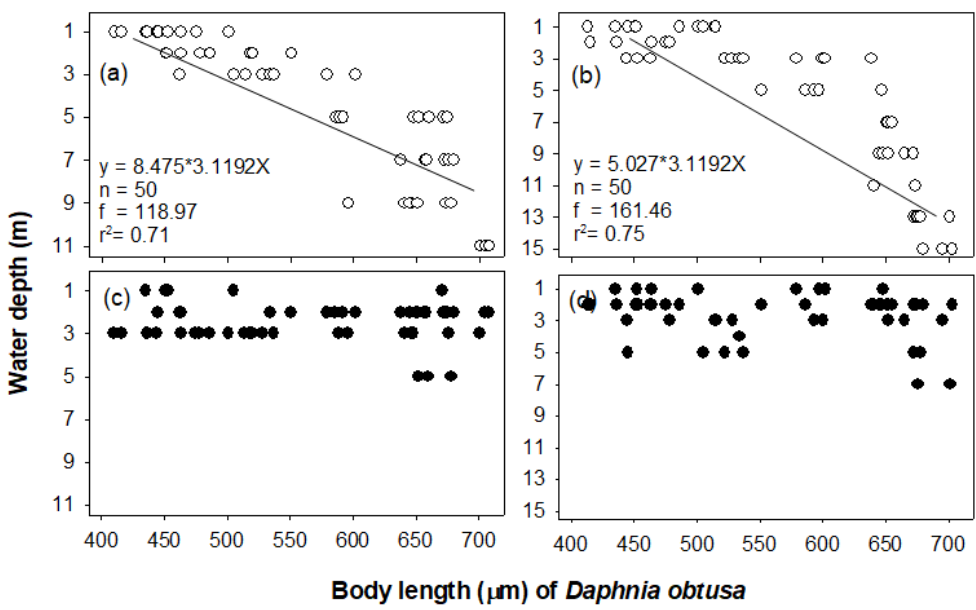
Figure 6. The relationship between body length (μm) of Daphnia obtusa and water depth during the daytime at sites 1 ( a ) and 3 ( b ) and during the night at sites 1 ( c ) and 3 ( d ).